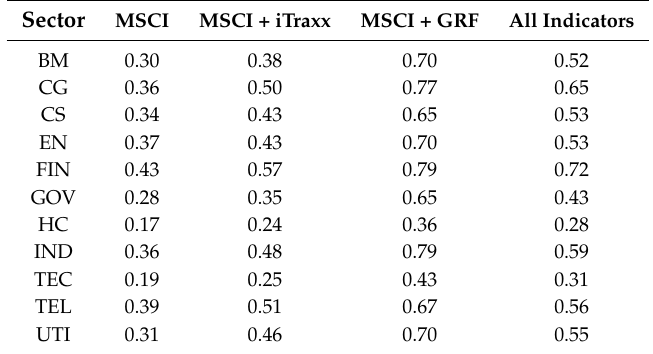
Table 6. Adjusted R2 statistics from alternative regressions explaining sectorial